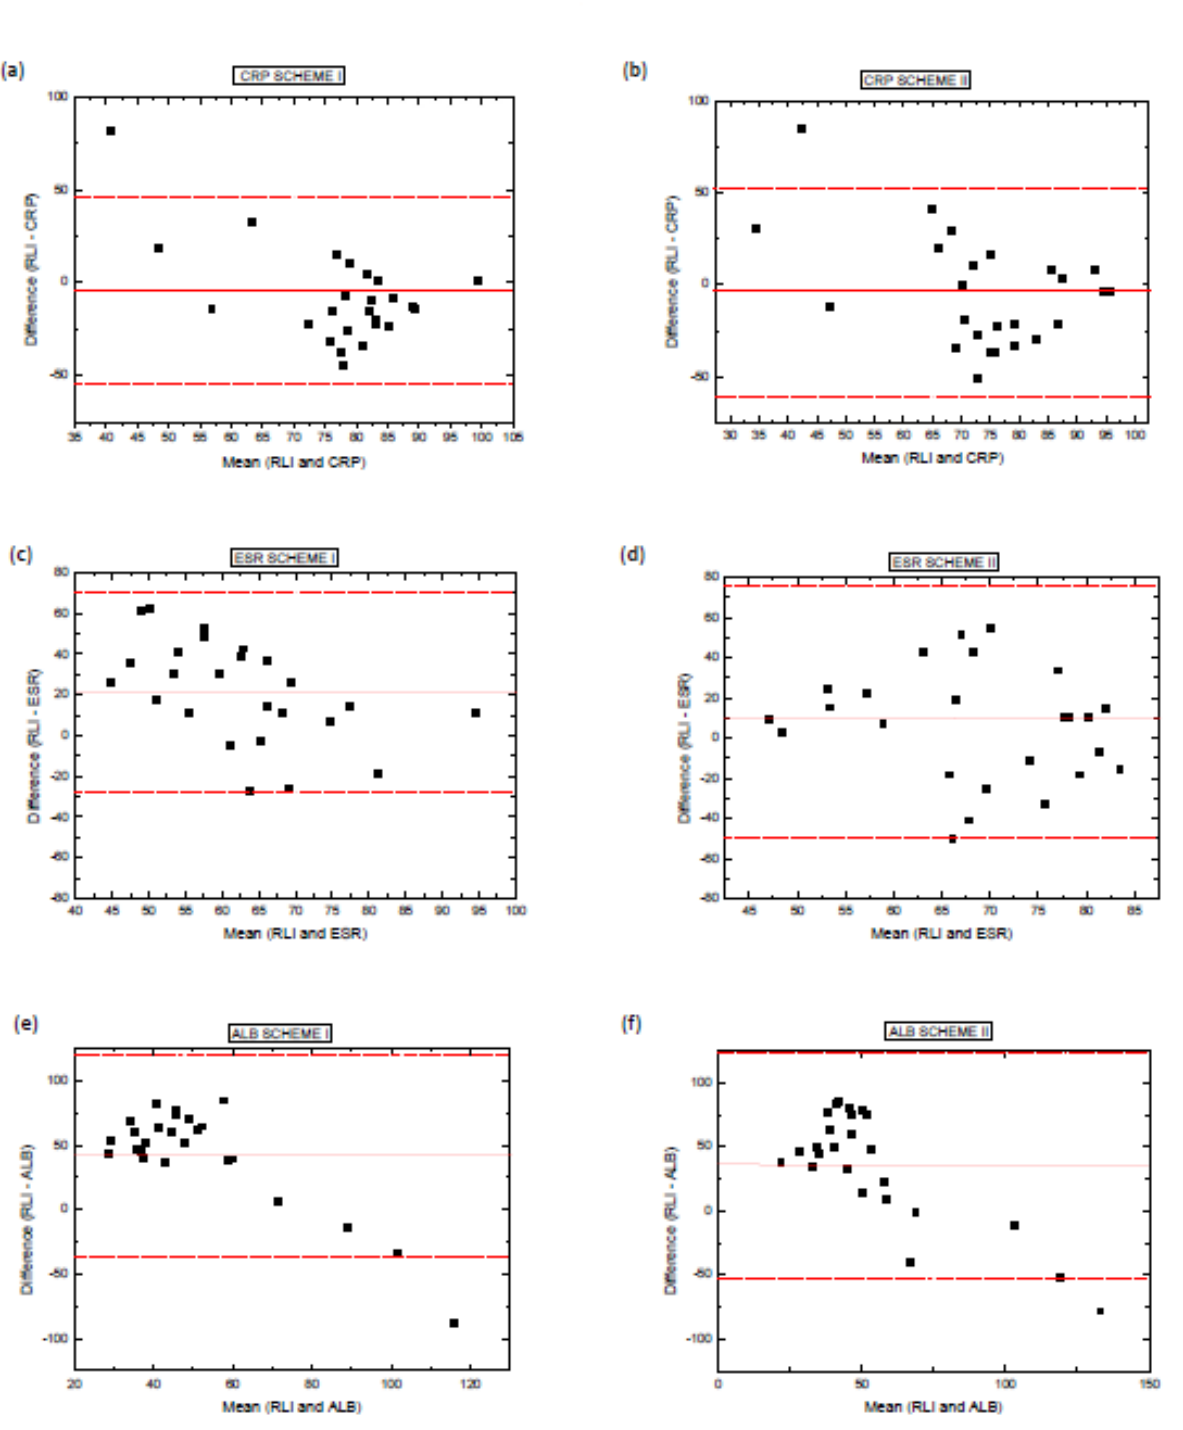
Figure 4 Bland-Altman plots for scores of: A) RLI and CRP for Scheme I; B) RLI and CRP for Scheme II; C) RLI and ESR for Scheme I; D) RLI and ESR for Scheme II; E) RLI and ALB for Scheme I; and F) RLI and ESR for Scheme II. The difference between methods was compared with the average between methods. Short dashed lines indicate the interval of two standard deviations, indicating an excellent level of statistical agreement between the